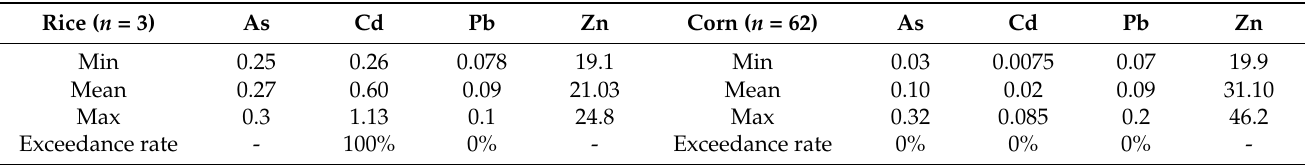
Table 5. Characteristics of heavy metals in crops ( µ